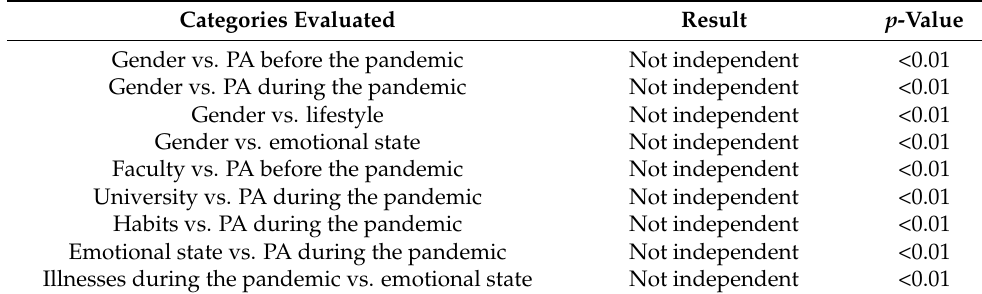
Table 3. χ 2 test (chi square) of stochastic independence. Categories Evaluated Result p -Value Gender vs. PA before the pandemic Not independent <0.01 Gender vs. PA during the pandemic Not independent <0.01 Gender vs. lifestyle Not independent <0.01 Gender vs. emotional state Not independent <0.01 Faculty vs. PA before the pandemic Not independent <0.01 University vs. PA during the pandemic Not independent <0.01 Habits vs. PA during the pandemic Not independent <0.01 Emotional state vs. PA during the pandemic Not independent <0.01 Illnesses during the pandemic vs. emotional state Not independent <0.01